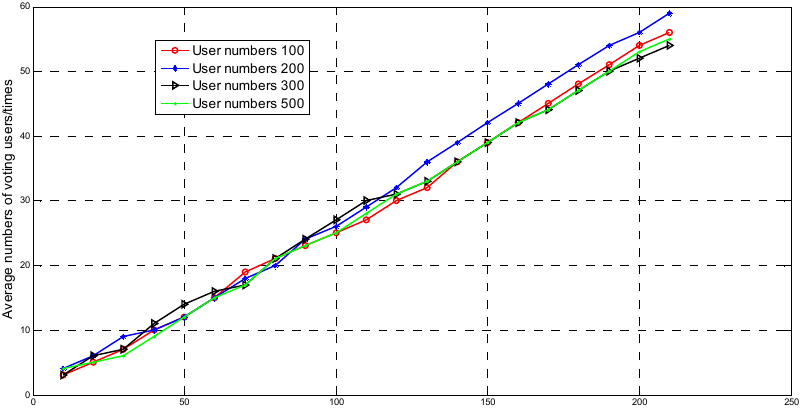
Figure 4. The number of voting users.